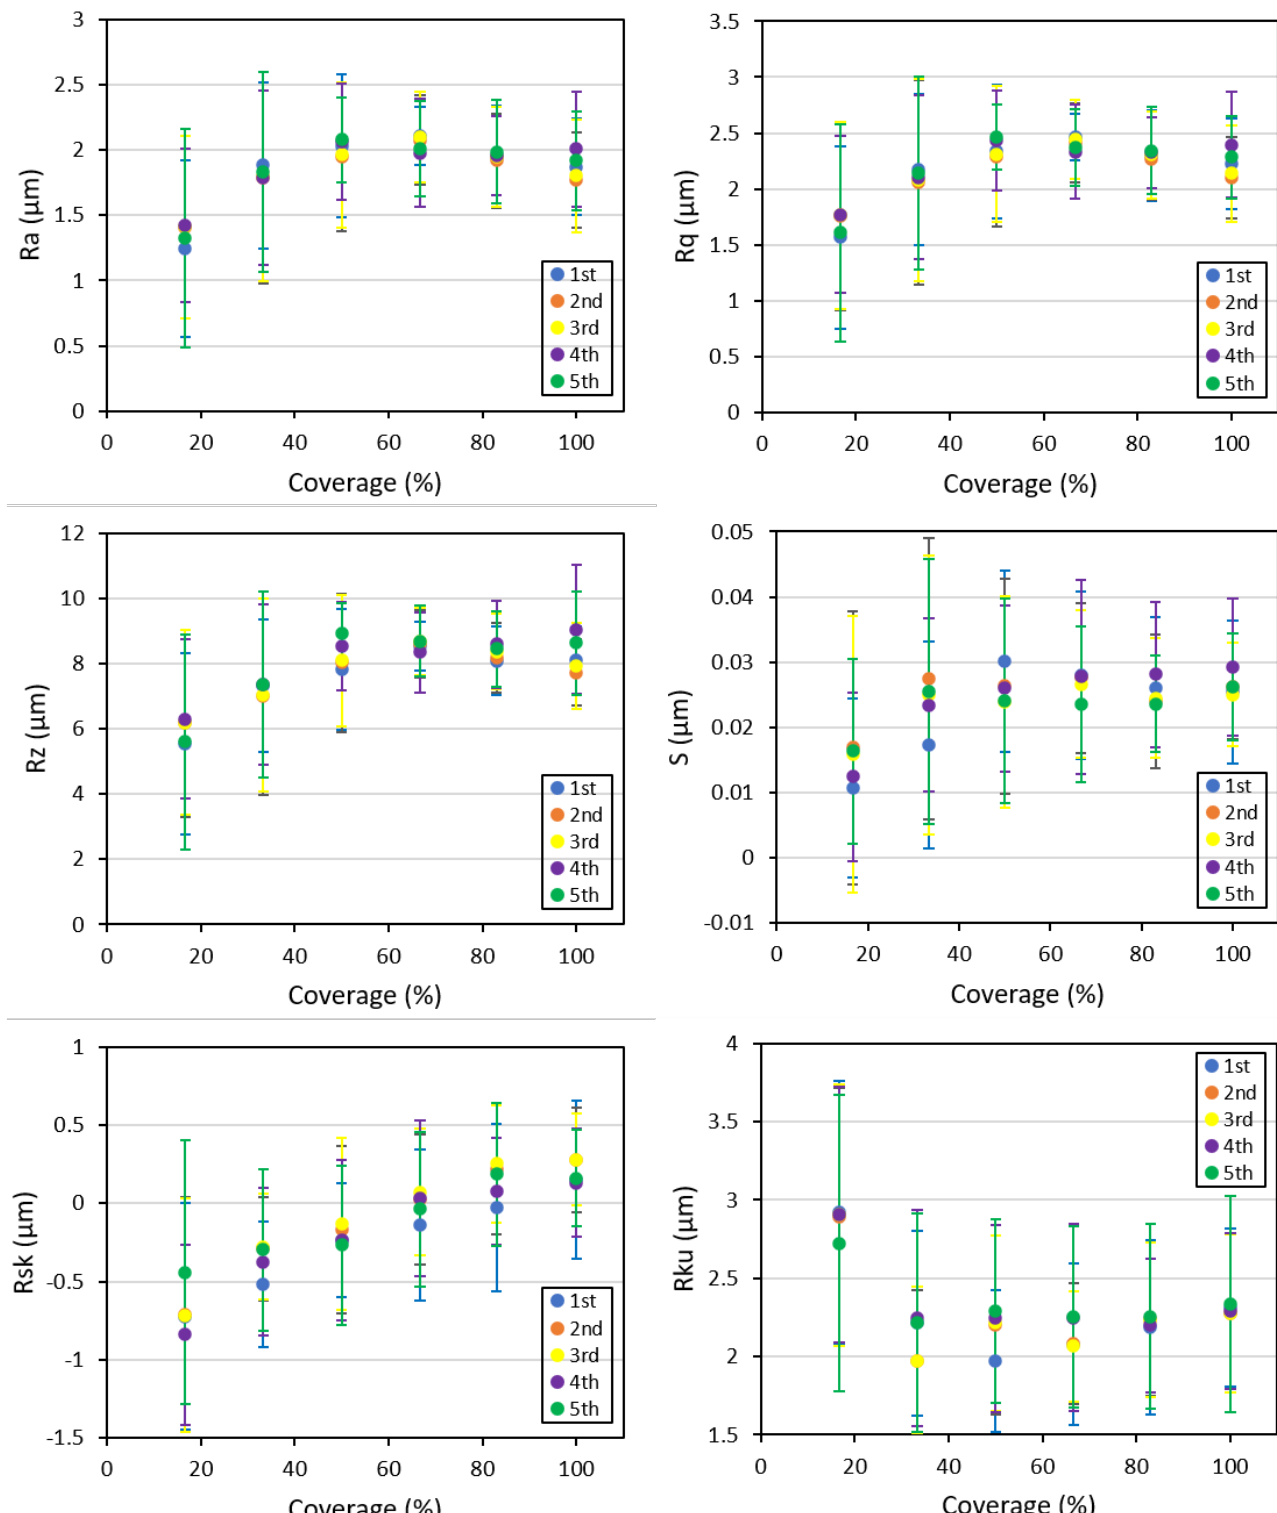
Figure 4. Numerical results on the evolution of select profile parameters as a function of surface